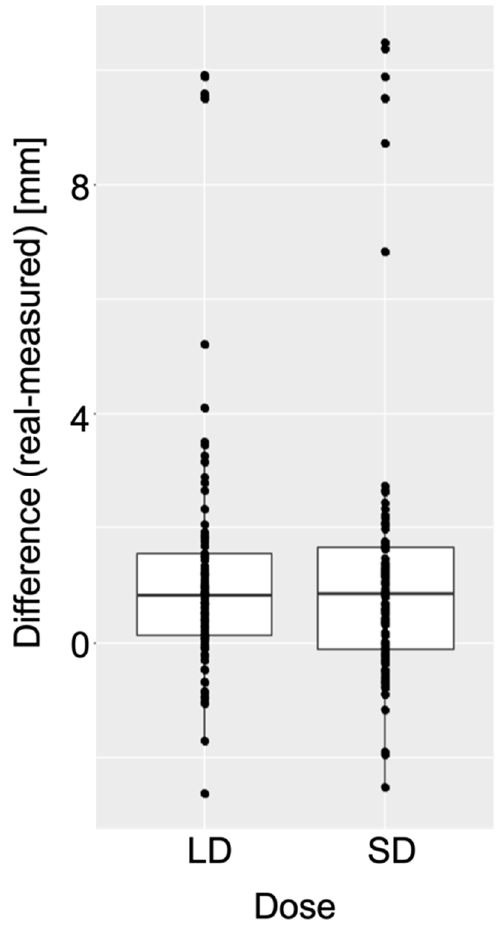
Figure 5. A Wilcoxon signed-rank test with continuity correction was performed based on a significance level of 5% to investigate whether the imaging protocols showed significant differences in their assessment with regard to lesion size. The difference between the measured and actual size of the lesion at its greatest extent in both imaging protocols is visualized. Both imaging protocols were found to perform very similarly with no statistically significant differences ( p = 0.46) and with an apparent underestimation of the actual distance in both the low ‐ dose and standard protocols.